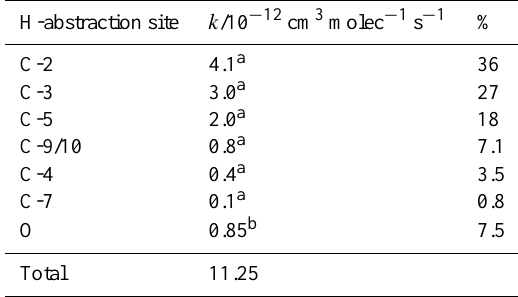
Table 2. Site specific and total rate coefficients for hydrogen ab- straction from pinonic acid by OH